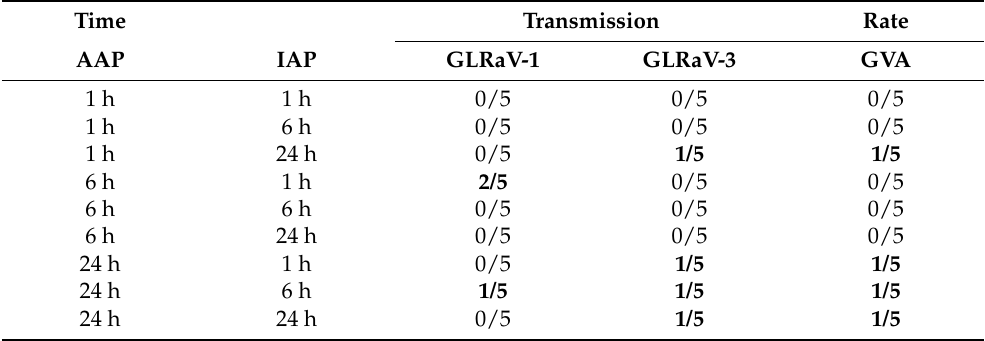
Table 9. Virus transmission rates of Heliococcus bohemicus L1 nymphs, according to AAP/IAP combinations. AAP on accession Y258. For each virus, transmission rate = number of positive vines/number of inoculated vines. Transmission events are highlighted in bold.